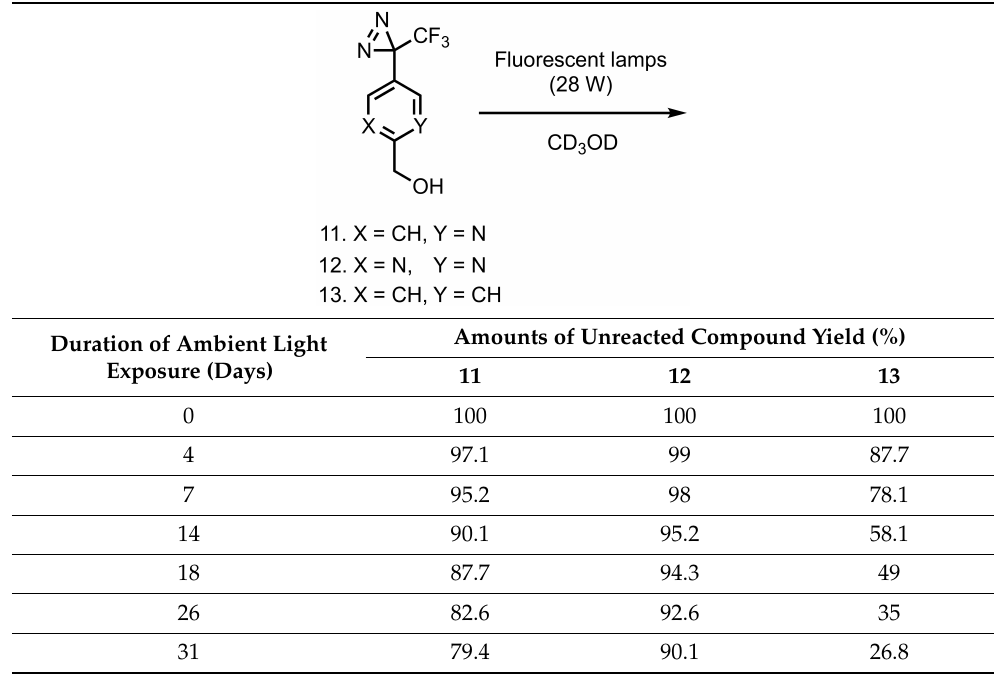
Table 1. Comparison of the ambient light stability of 11 and 12 versus that of (4-(3-(trifluoromethyl)- 3 H -diazirin-3-yl)phenyl)methanol 13.